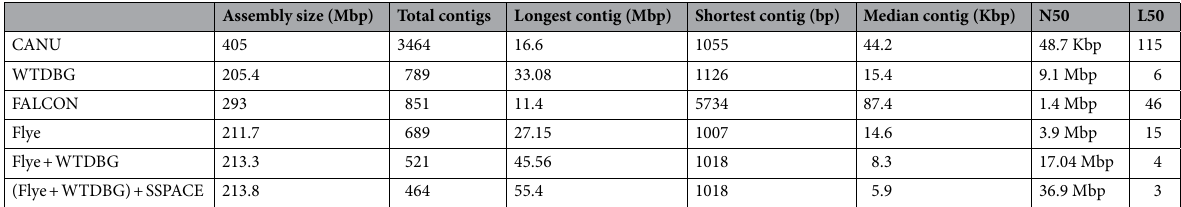
Table 1. Statistics of contig-level assemblies by CANU, FALCON, FLYE, and WTDBG2